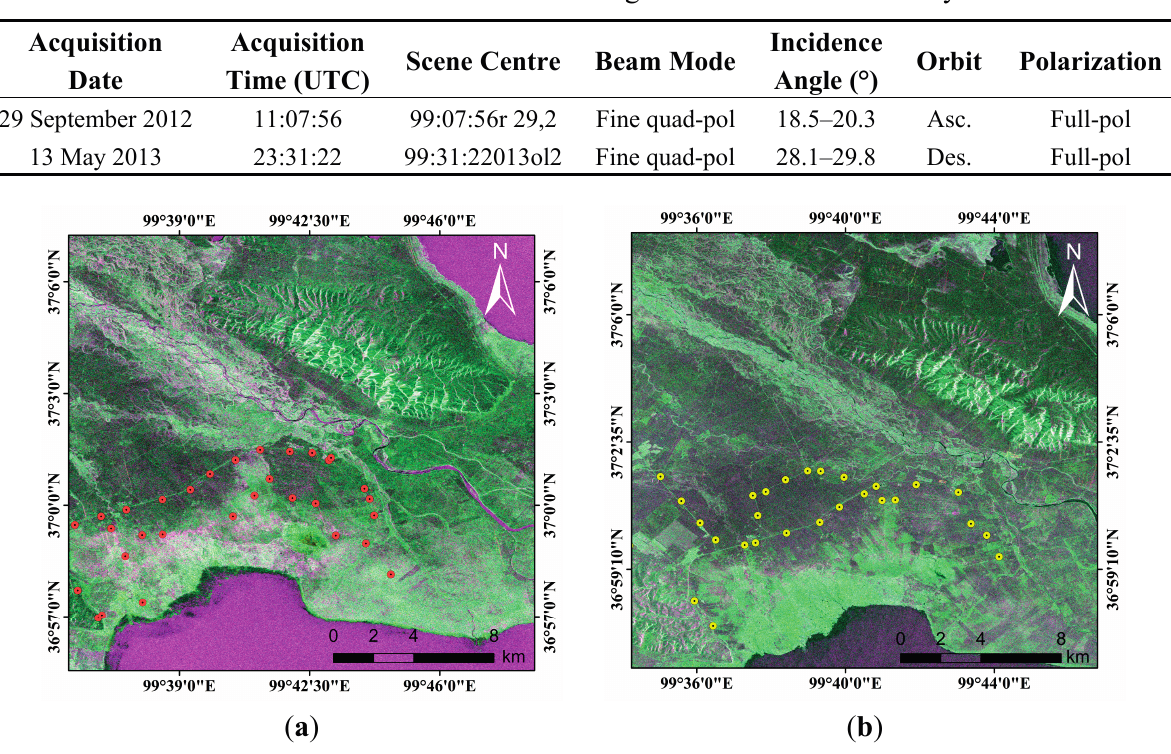
Figure 2. RADARSAT-2 composite false RGB images (HH = red, HV = green, VV =